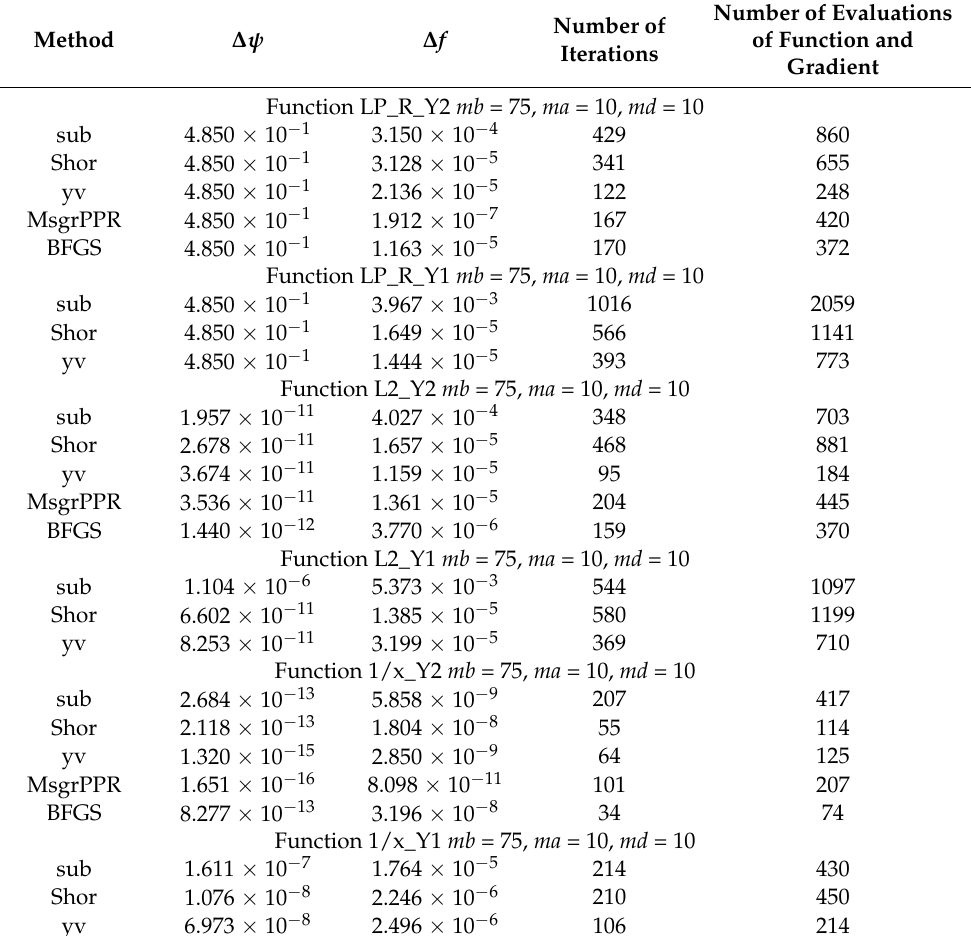
Table 5. Results of calculations for dimensions n = 1000, m = 100 with mb =